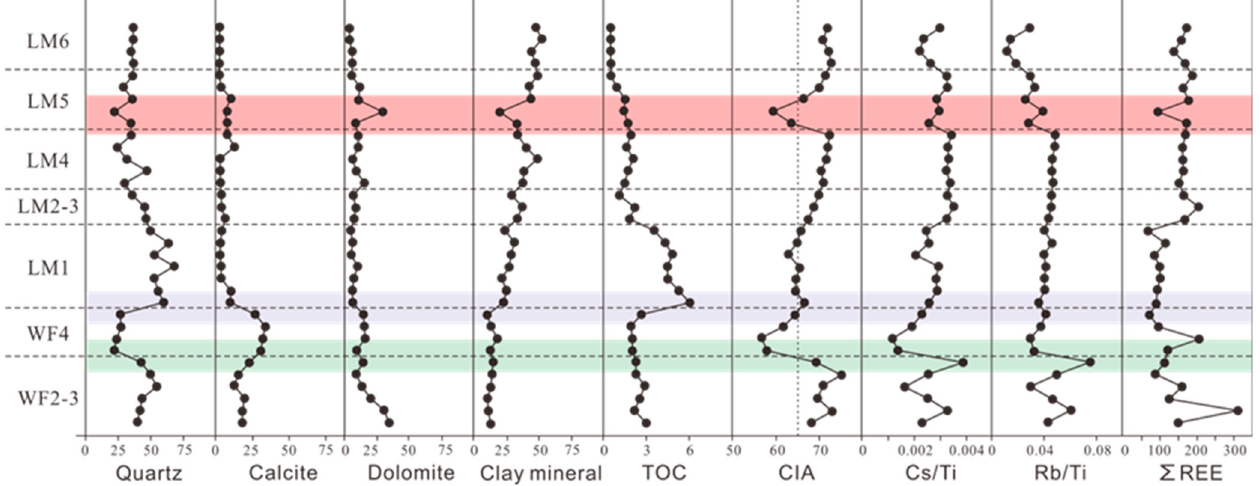
Figure 6. Variations in contents of some mineral compositions (%) [48], TOC contents (%), chemical index of alteration (CIA), Ti-normalized ratios, and total rare-earth elements ( ∑ REE) showing the change in lithology and paleoclimate.